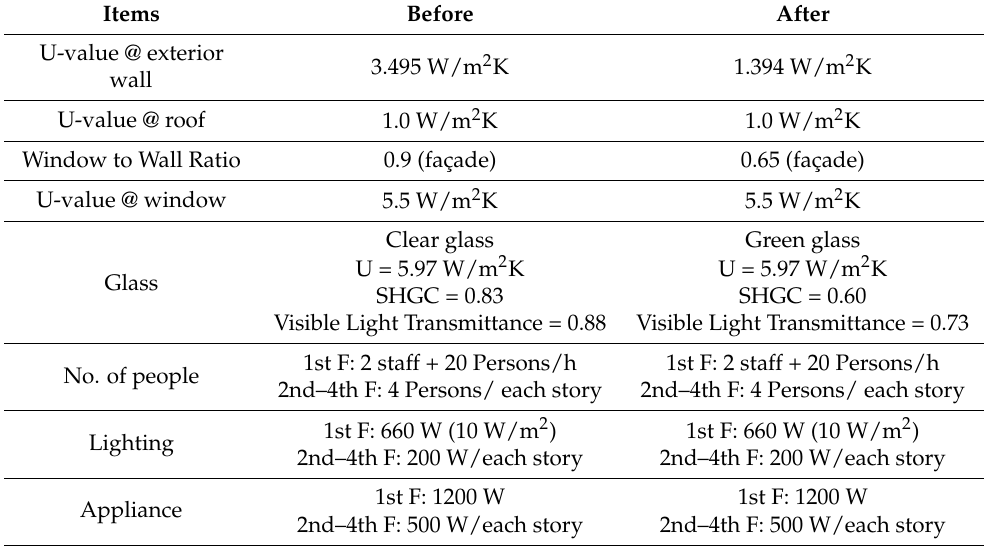
Table 5. Physical parameters for the